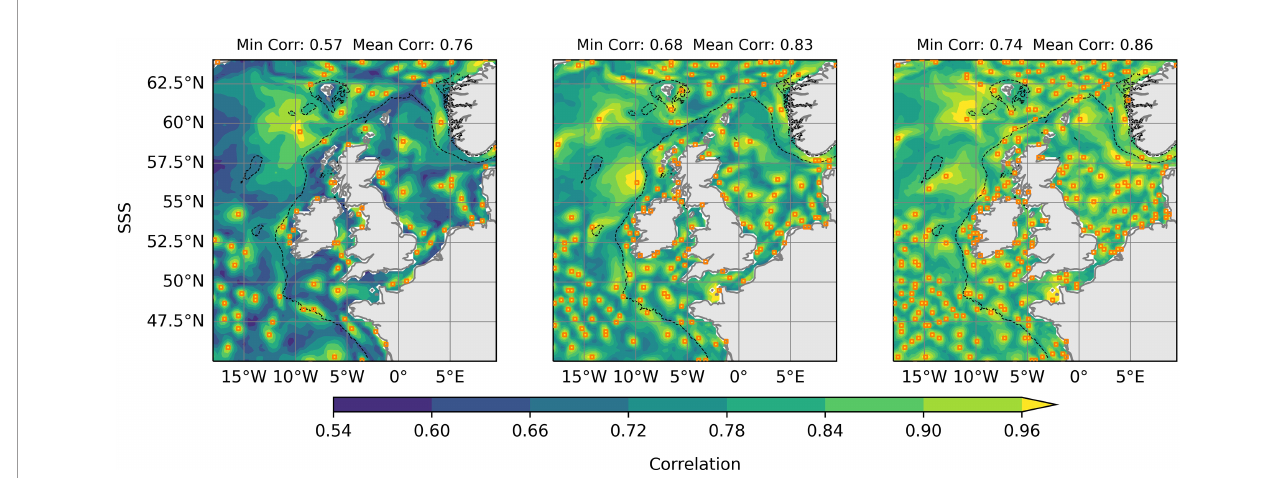
FIGURE 5 | ‘ Best ’ correlations with an observation location for the Modi fi ed Greedy Set Cover algorithm. The algorithm has been run for N = 100, 200 and 300, shown from left to right respectively. Orange squares show the suggested observation